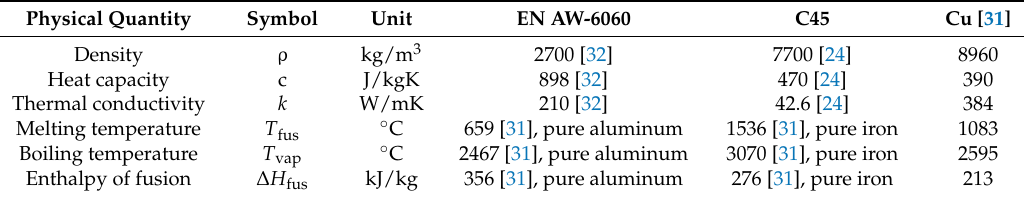
Table 4. Material specific values (temperature independent during the simulations).